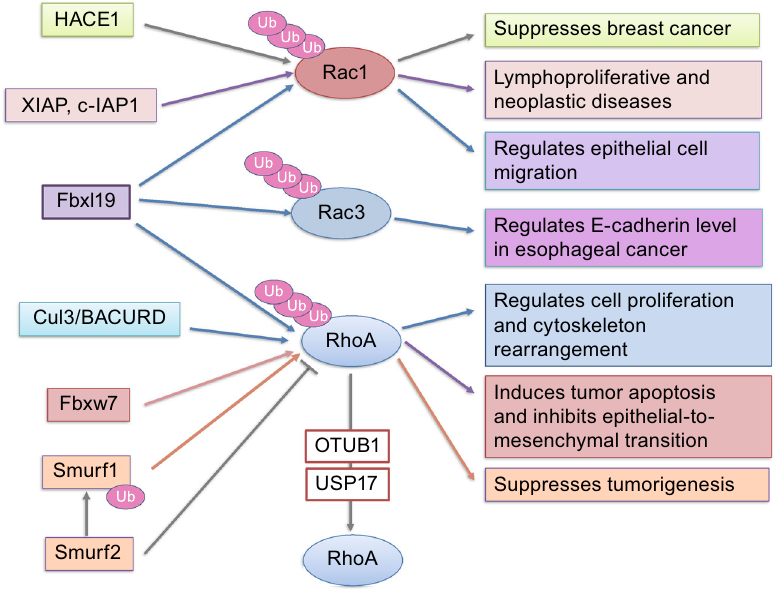
Figure 4. Overview of ubiquitination and deubiquitination of Rho GTPases and their effects on Rho GTPases biological functions. Rac1 is ubiquitinated by E3 ligases, HACE1, XIAP, c-IAP1, and Fbxl19. Rac3 is ubiquitinated by Fbxl19. RhoA is ubiquitinated by Fbxl19, Cul3/BACURD, Fbxw7, and Smurf1. Smurf2 negatively regulates Smurf1, thus stabilizing RhoA. OTUB1 and USP17 deubiquitinate and stabilize RhoA. Regulation of Rho GTPase stability controls tumorigenesis, cytoskeleton rearrangement, and cell